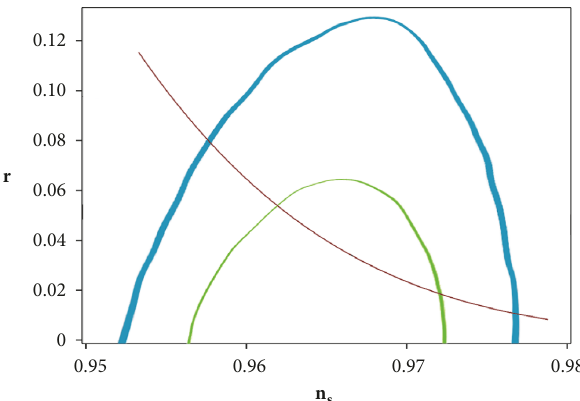
Figure 1: Tensor-to-scalar ratio versus the scalar spectral index in the background of Planck2015 TT,TE, and EE+lowP data.